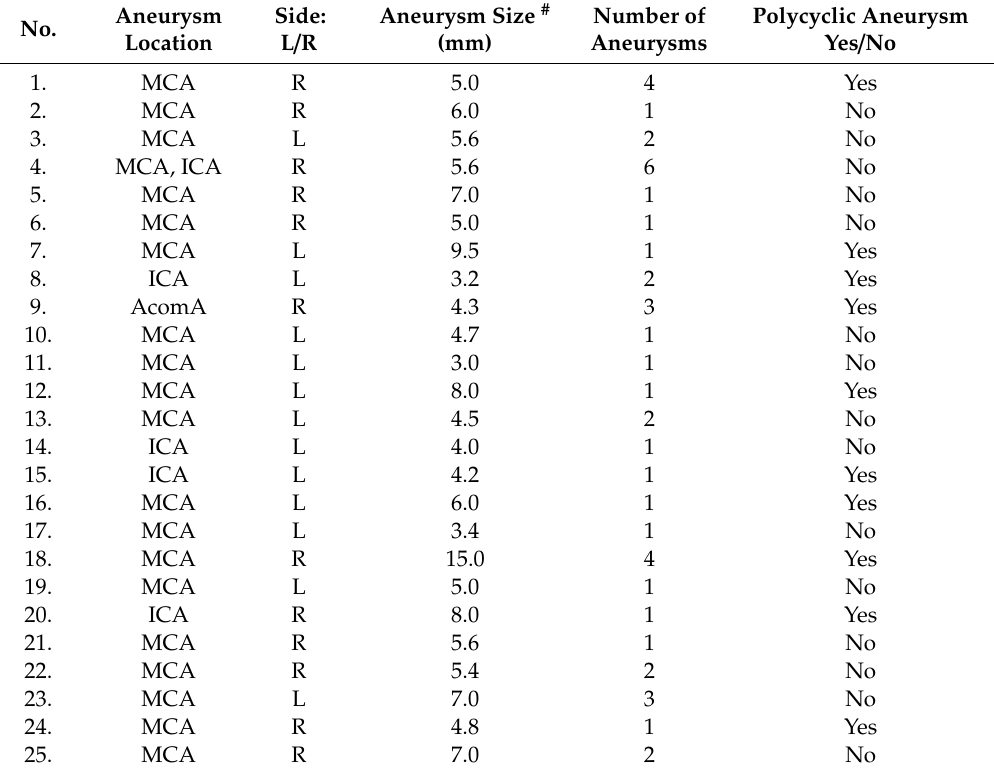
Table 2. Aneurysm geometry